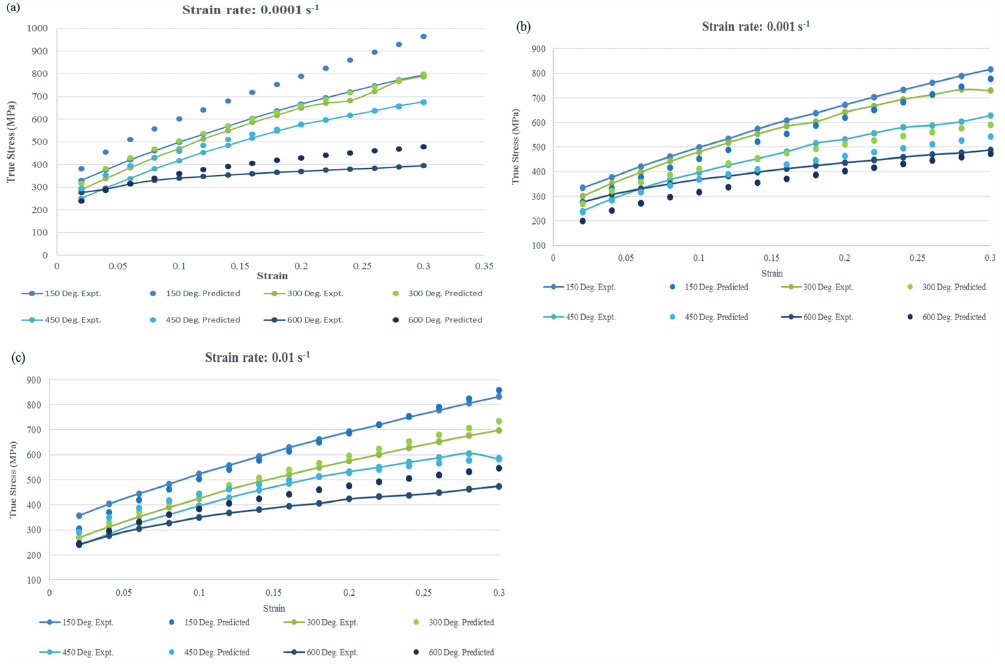
Figure 3: Comparison of experimental and predicted flow stress for m-FB model for ASS 304 for strain rates of (a) 0.0001 s − 1 (b) 0.001 s − 1 (c) 0.01 s − 1 .